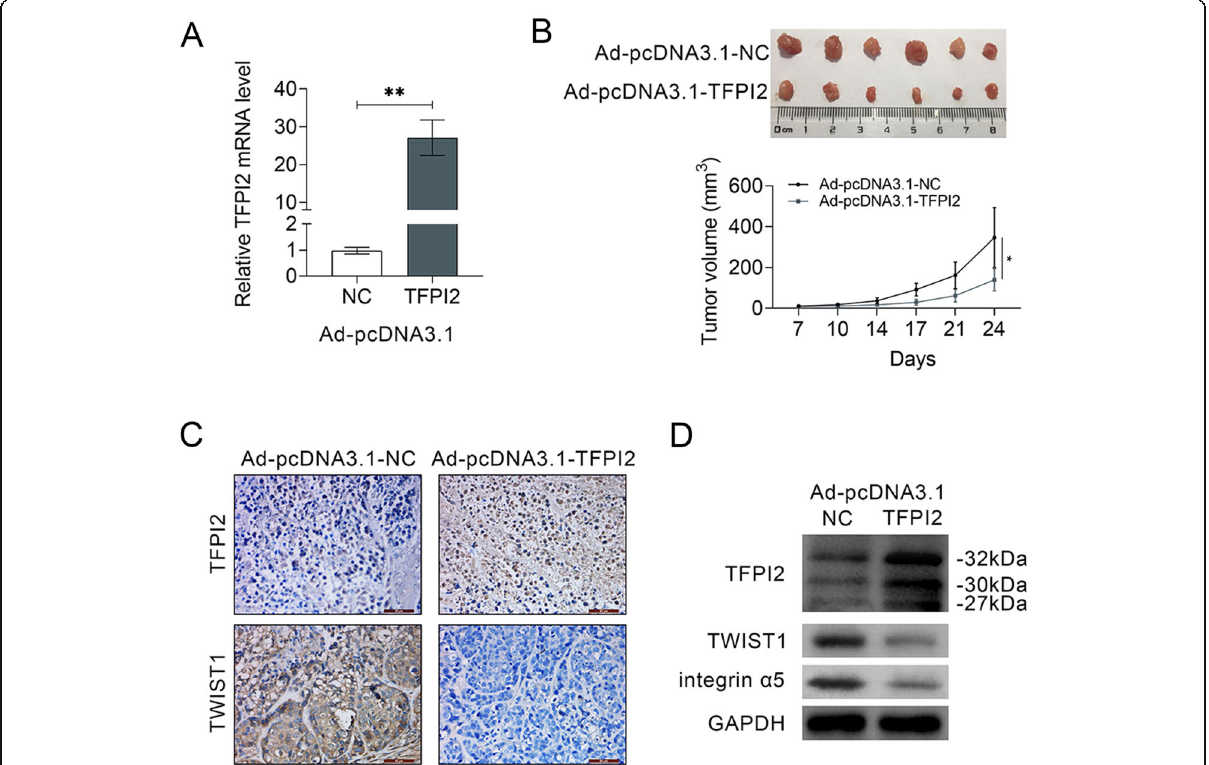
Fig. 6 TFPI2 over-expression inhibited in vivo breast cancer tumor growth. a Transfection efficiency of Ad-pcDNA 3.1-TFPI2 in nude mice, suggesting up-regulation in mice injected with Ad-pcDNA 3.1-TFPI2. ** represents Ad-pcDNA 3.1-TFPI2 vs. Ad-pcDNA 3.1-NC, p < 0.01. b Injection of Ad-pcDNA 3.1-TFPI2 inhibited breast cancer tumor growth and volume. * represents Ad-pcDNA 3.1-TFPI2 vs. Ad-pcDNA 3.1-NC, p < 0.05. c Immunohistochemistry analysis of TFPI2 and TWIST1 in tissues of mice intratumoral injected with Ad-pcDNA 3.1-TFPI2 or Ad-pcDNA 3.1-NC, suggesting up-regulation of TFPI2 and down-regulation of TWIST1 in mice injected with Ad-pcDNA 3.1-TFPI2. d Injection of Ad-pcDNA 3.1-TFPI2 promoted on proteins expression of TFPI2, while inhibited TWIST1 and integrin α 5 in xenograft tumor